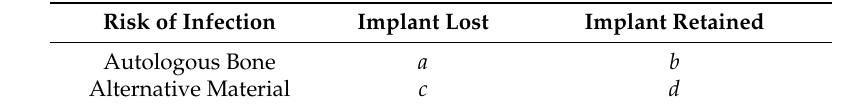
Table 2. Relative Risk Calculation